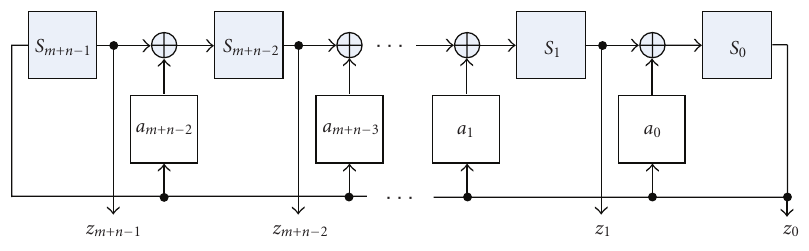
Figure 1: A linear feedback shift register